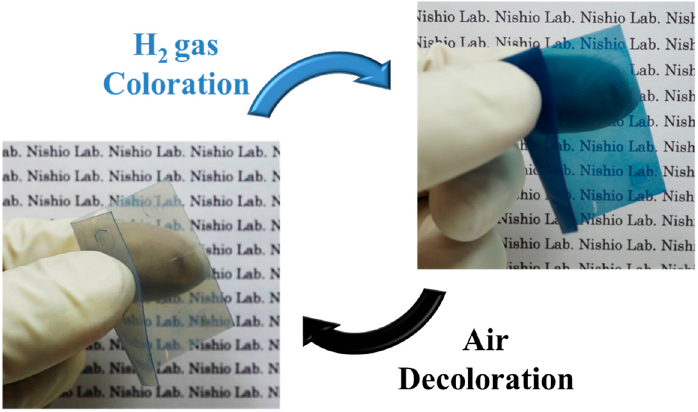
Figure 7. Hydrogen gas responsivity, transparency, and flexibility of the Pt/WO 3 particle-containing membrane. (Pt:W ＝ 1:13; heat treatment at 573 K; particle concentration of 0.75 wt.%; exposed to the H 2 gas concentration of 100%) .